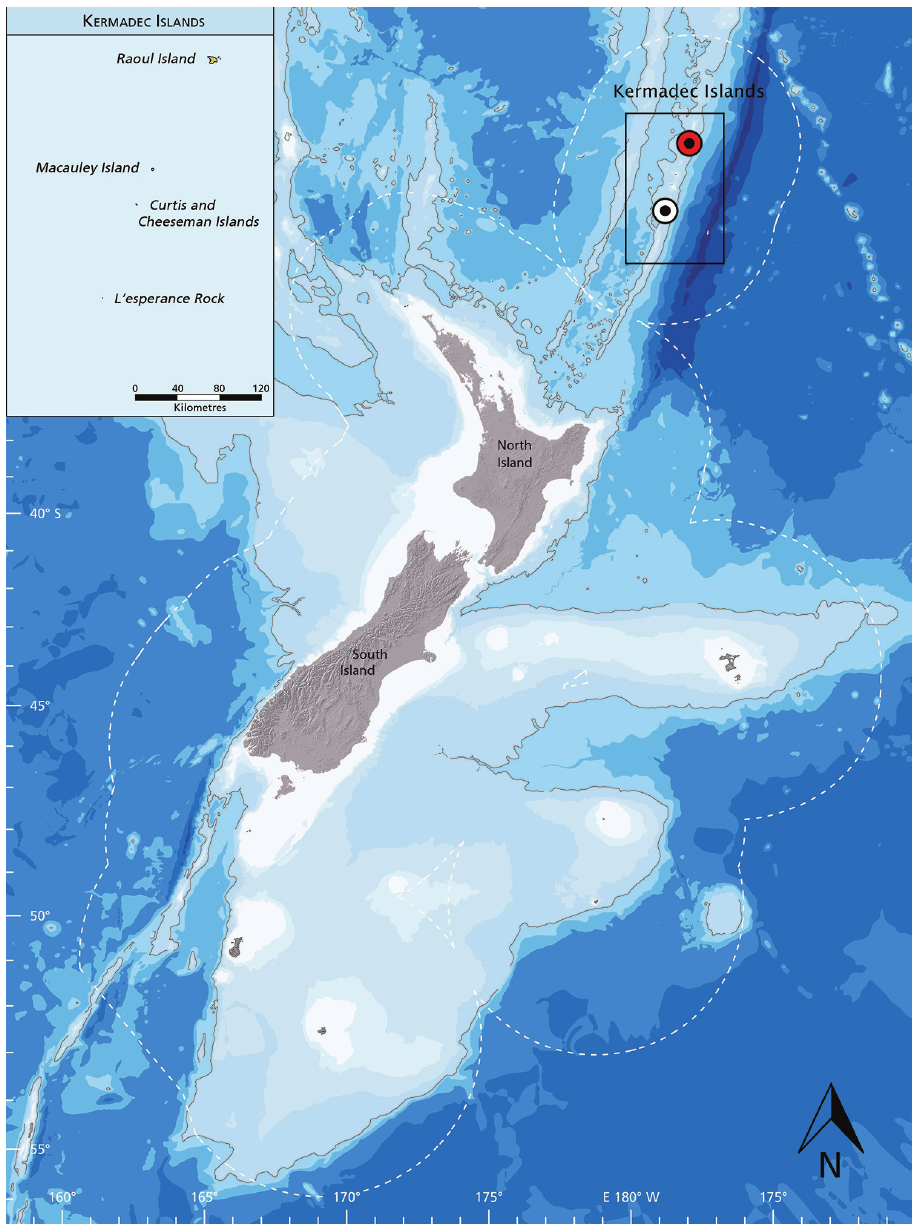
Figure 11. Distribution of Flexor incus . Type locality in red.